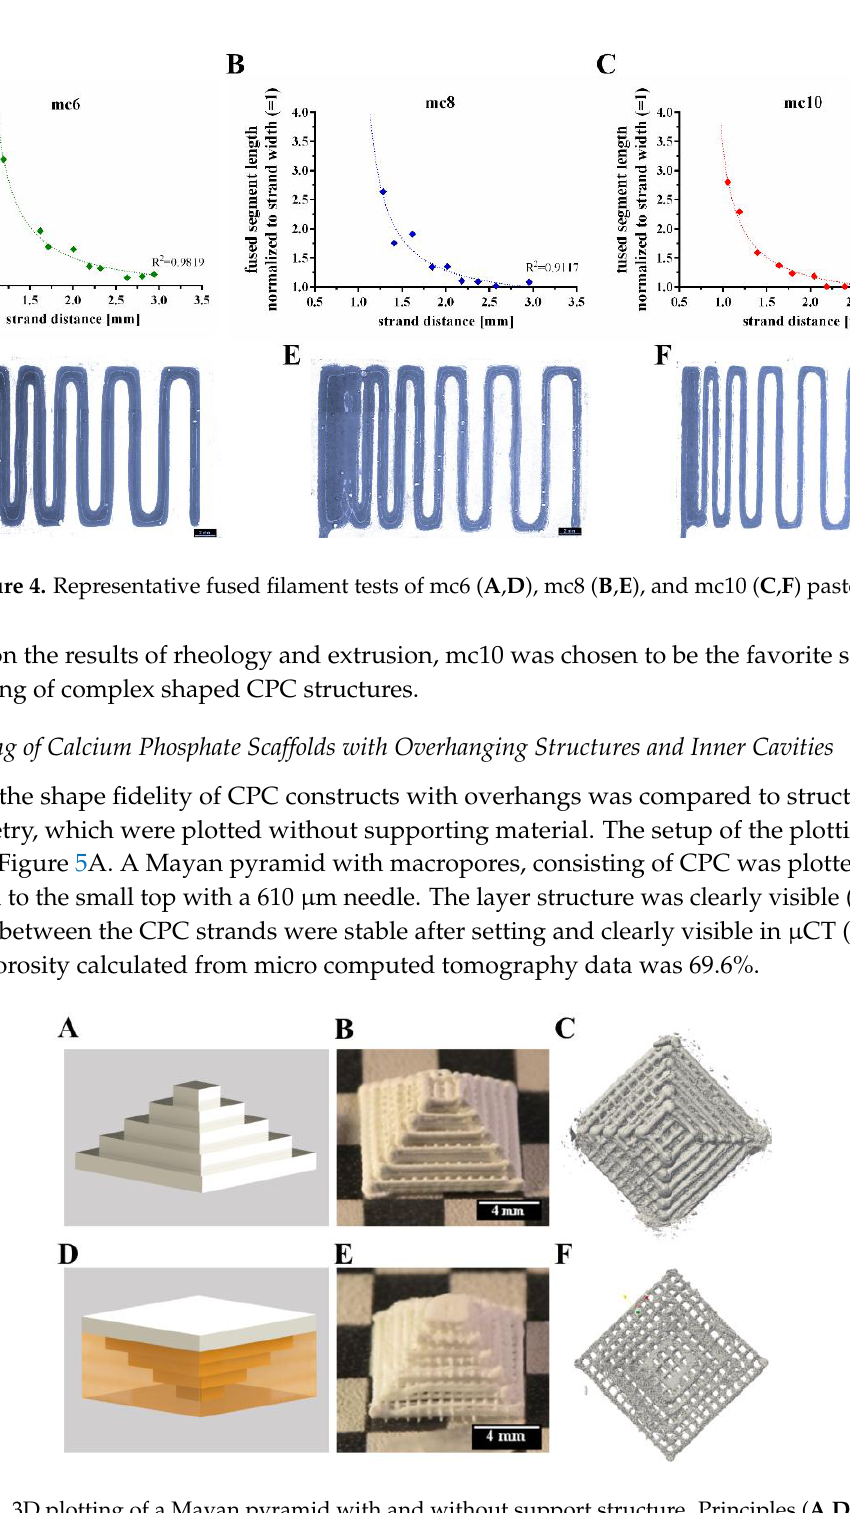
Figure 5. 3D plotting of a Mayan pyramid with and without support structure. Principles ( A , D ) show the calcium phosphate cement (CPC) in white and mc in yellow. The upright and the inverted pyramids ( B , C & E , F ) revealed no changes of the inner structures, but at the borders. In contrast to a Mayan pyramid, there are structures which cannot be plotted without